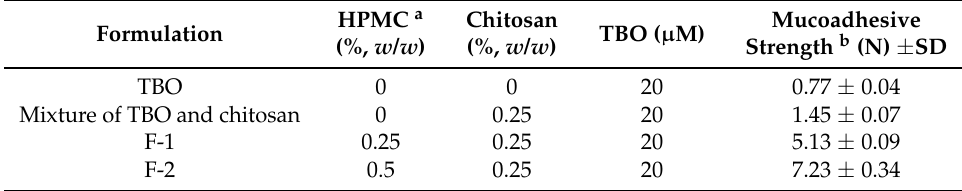
Table 1. Composition and mucoadhesive characteristics of the chitosan hydrogel and comparison with control groups.